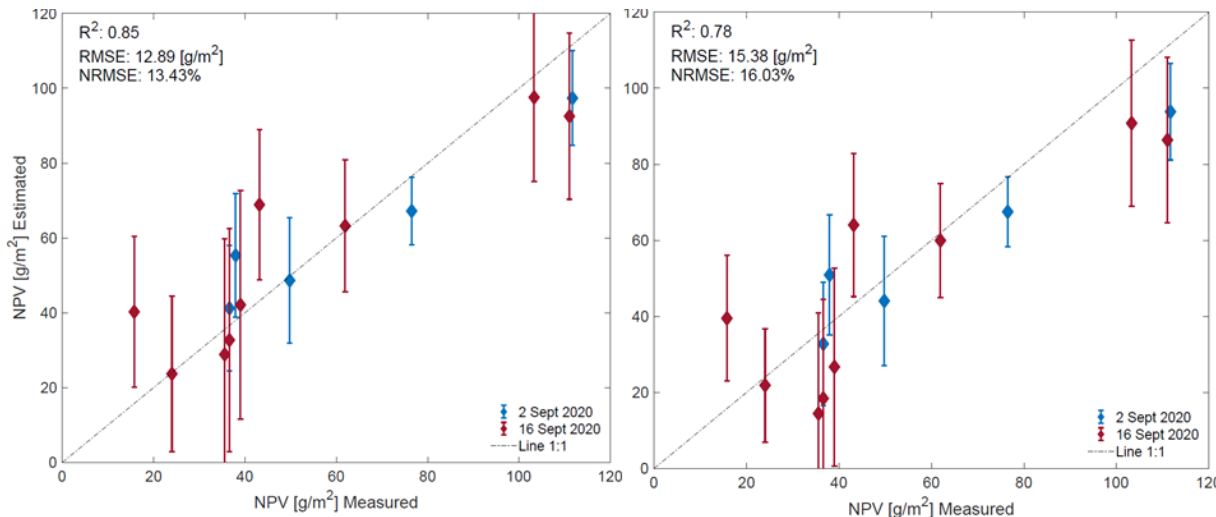
Figure 6. Measured vs estimated non-photosynthetic cropland biomass along 1:1-line including uncertainty intervals for EBD-optimized training data set ( left ), and EBD-optimized + 24 added non-vegetated (NV) spectra ( right ).